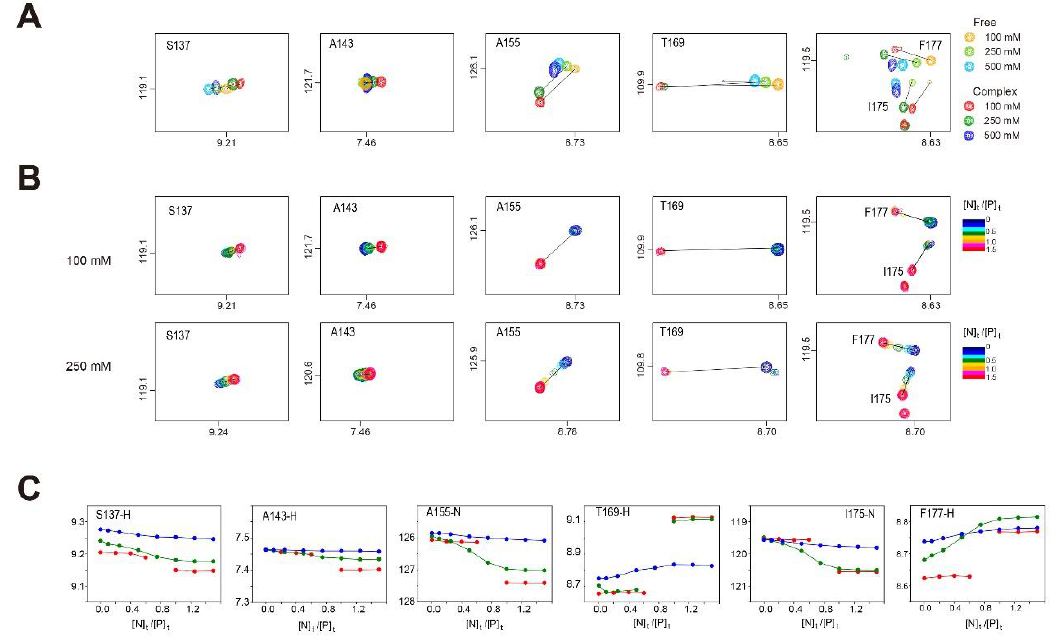
Figure 5. ( A ) Comparison of 1 H/ 15 N-HSQC peaks of S137, A143, A155, T169, I175, and F177 in free Dlx3-HD and Dlx3-HD – dlxDNA complex ([N] t /[P] t = 1.5) at 100, 250, or 500 mM NaCl at 35 °C. ( B ) Comparison of 1 H/ 15 N-HSQC peaks of S137, A143, A155, T169, I175, and F177 of Dlx3-HD at 100 mM (upper) or 250 mM NaCl (lower) at 35 °C. The cross-peak color changes gradually from dark blue (free) to red (complex) according to the [N] t /[P] t ratio. ( C ) Chemical shift values of S137-H, A143-H, A155-N, T169-H, I175-N, and F177-H signals of Dlx3-HD upon titration with dlxDNA as a function of the [N] t /[P] t ratio at 100 (red), 250 (green), or 500 mM NaCl (blue) at 35 °C. 3. Discussion TDO syndrome has been linked to a frameshift mutation (GGGG deletion in DLX3 gene) just downstream of the Dlx3-HD [14,15]. Interestingly, the missense-type mutations in Dlx3-HD are also able to cause TDO syndrome [6,18,19,22]. The substitutions of Q178 by Arg (Q178R mutant) [6,19] and of S182 by Phe (S182F mutant) [18] are causative muta- tions for TDO. A structural study revealed that residues Q178 (Q186 in Dlx5) and S182 (S190 in Dlx5) in the α 3 helix of Dlx3-HD interacted with the T4 and T5 bases in the con- sensus DNA (Figure 1) [21]. Our study found that the T4 imino resonance was signifi- cantly down-field shifted by complex formation with Dlx3-HD (Figure 2C). In addition, the neighboring N179 and R180 resonances showed larger chemical shift changes upon binding to dlxDNA (Figure 4). It has also been reported that the R133P mutation in the L1 loop region of Dlx3-HD results in TDO syndrome [18]. According to the structural study [21], R133 formed H-bonding interactions with the T1 base of DNA (Figure 1). Data from a 1D imino NMR showed that the T1 imino resonance completely disappeared upon bind- ing to Dlx3-HD (Figure 2C), indicating destabilization of the T1·A1 ’ base-pair. The CSP data showed that the I135 and Y136 amide signal located near R133 disappeared upon binding to DNA (Figure 4A). These data meant that residues R133, Q178, and S182 play important roles in target DNA recognition, which might be associated with TDO syn- drome. Salt concentration can have a dramatic effect on protein functions such as enzymatic catalysis, ligand binding, and DNA binding [23 – 27]. Our study found that Dlx3-HD has a strong binding affinity to consensus DNA duplex at [NaCl] = 250 mM (Figure 4), although the increment of [NaCl] from 100 to 250 mM leads to significant chemical shift changes in the amide resonances of free Dlx3-HD (Figure 3). This increment of [NaCl] made the Dlx3- HD-DNA interaction more dynamic, which was confirmed by fast exchange behavior in